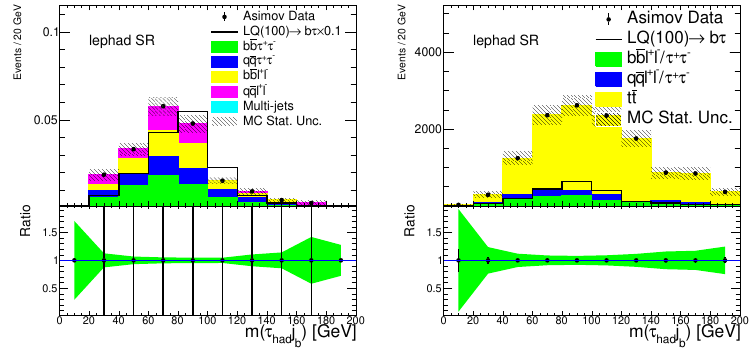
Figure 12 . The distribution of the invariant mass of a hadronic tau candidate and a b -jet candidate in the Pb-Pb collisions (L) and the p - p collisions (R). The signal histograms are scaled by a factor of 10 − 2 besides the scaling factor in the legends. The black points in the upper pads show the asimov data which is just the sum of all background events with uncertainties completely suppressed for better illustration. The ratio of the asimov data and the total background is shown in the lower pads, where the error bars on the black points represent the expected data uncertainty while the green bands represent the total MC statistical